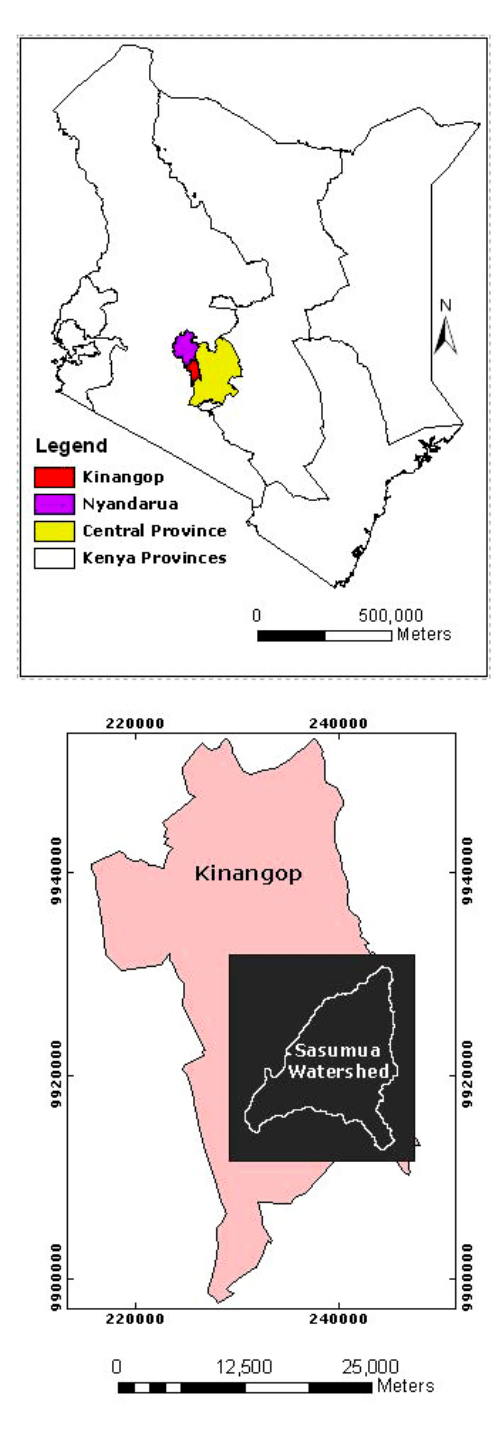
Fig. 2 . Location of Sasumua